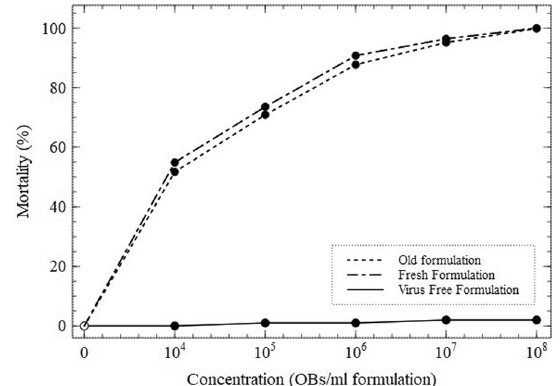
Fig. 1 Concentration response values of crude virus, two formulation forms and virus-free formulation on third instar Hyphantria cunea